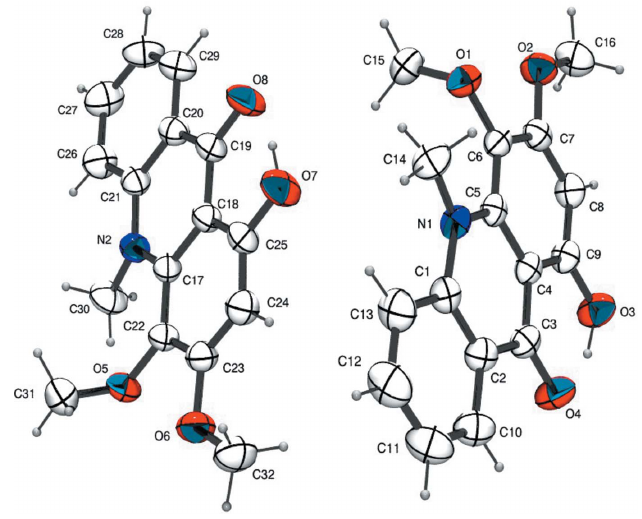
Figure 1 The asymmetric unit of the title compound showing the atom labelling and 50% probability displacement